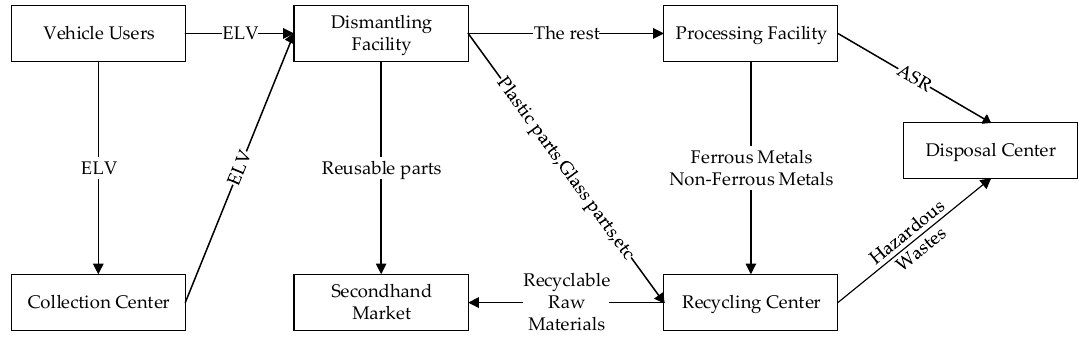
Figure 2. The reverse logistics process of end-of-life vehicles (ELVs) [11].